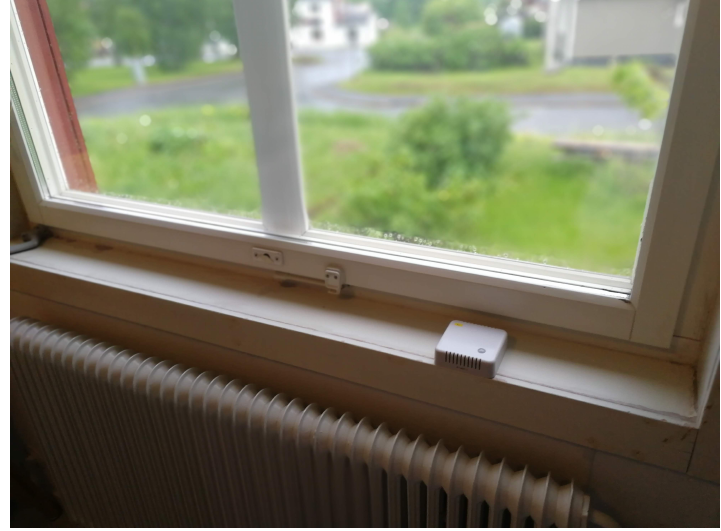
Figure 5. Sensor E8 beside a 2 layer glass window inside of a wooden